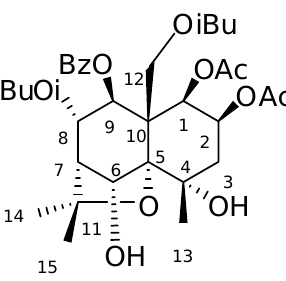
Figure 1. Structure of